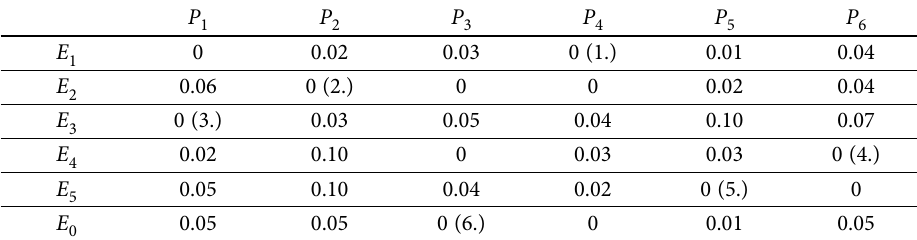
Table 7. Aggregated results with the Hamming distance